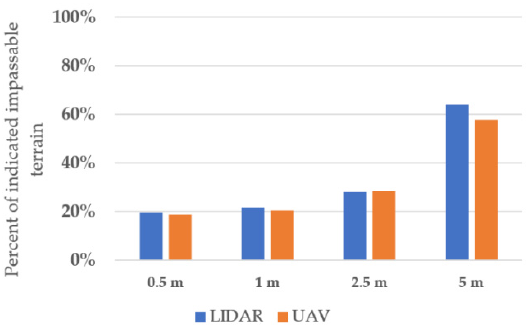
Figure 20. Comparison of the percent of impassable terrain (Honker vehicle, bluff terrain, 0.5 m pixel size) from elevation models from different data sources.